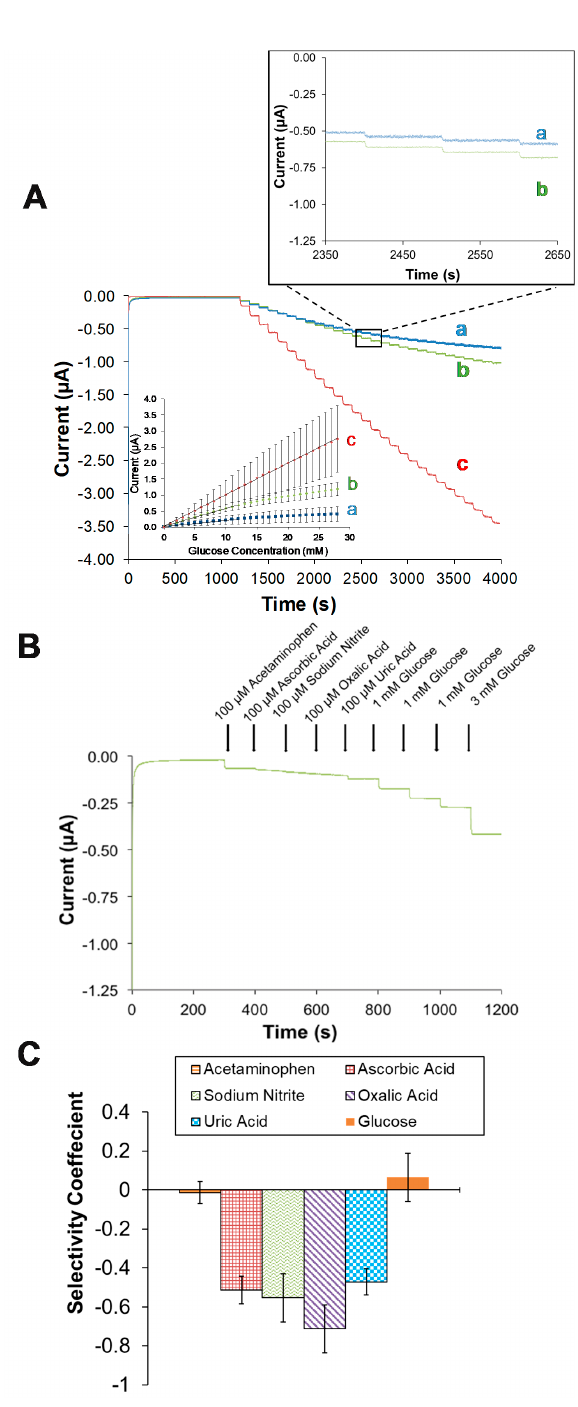
Figure 2. ( A ) Typical amperometric I-t response and corresponding calibration curve (inset) during successive 1 mM injections of glucose at a (a) Pt wire electrode, (b) Pt-Ir wire electrode, and (c) Pt macroelectrode modified with GOx-doped OTMS xerogel, undoped OTMS xerogel, polyphenol (PP), polyurethane layer (50:50), and epoxy cap; ( B ) Typical amperometric I-t response and ( C ) calculated selectivity coe ffi cients during successive injections of common interferent species (100 µ M) and glucose (1 mM and / or 3 mM) at a Pt-Ir wire electrode modified with the same four layers described in (A). Notes: Soln. is 60.0 mM PBS, pH = 7.4, µ = 155 mM (wires) and 4.4 mM PBS, pH = 7.0 (macroelectrode). Note: Error bars represent standard error (n ≥